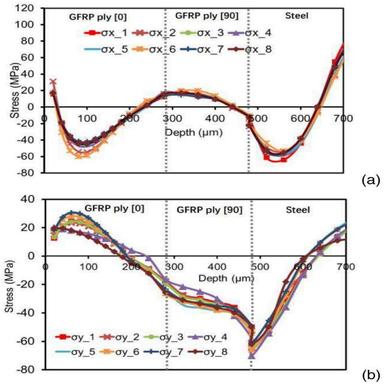
σx (a) and (b) σy in a GFRP/steel/GFRP sample experimentally determined by IHD.